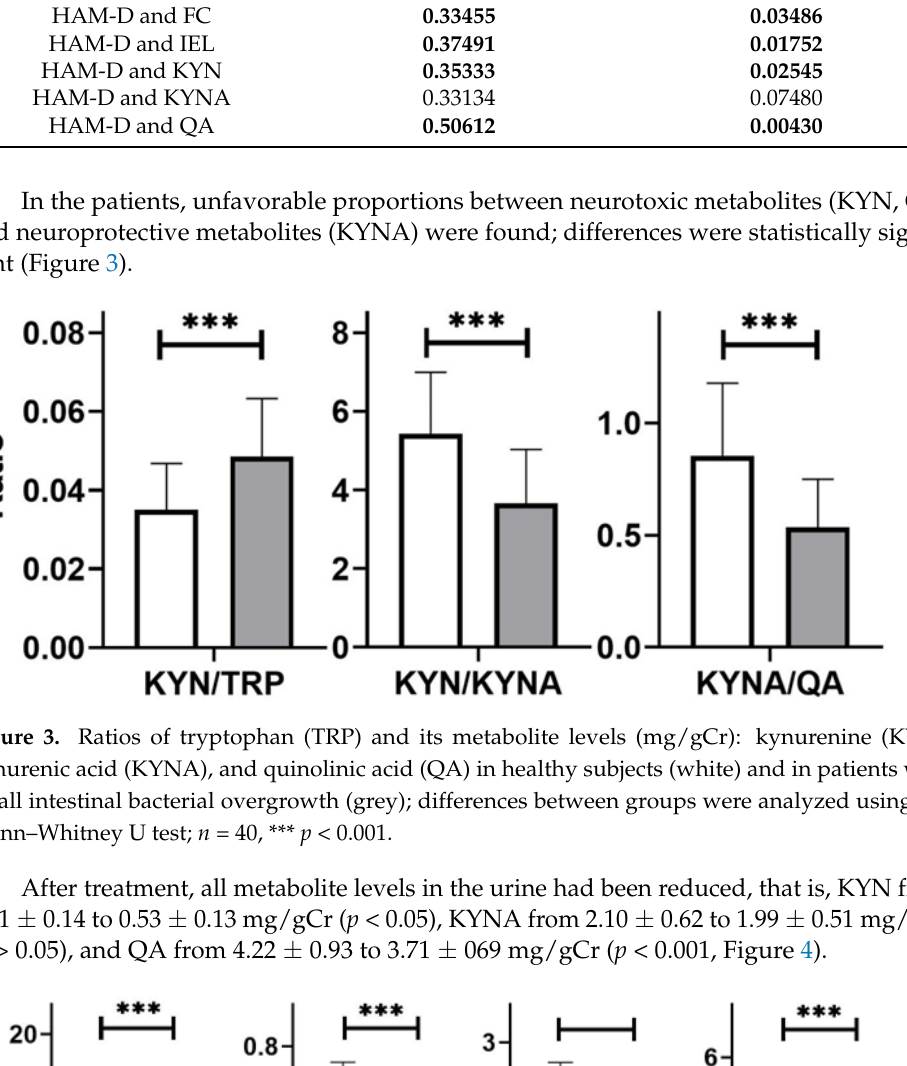
Table 2. Correlation between the Hamilton Depression Rating Scale (HAM-D) score and laboratory data; LHBT — hydrogen breath test, CRP — C -reactive protein, FC — fecal calprotectin, IEL — intraep- ithelial lymphocytes, KYN — kynurenine, KYNA — kynurenic acid, QA — quinolinic acid in 40 pa- tients ’ small intestinal bacterial overgrowth. The correlations were analyzed using the Spearman test. Significant p -values are highlighted in bold. A Pairs of Variable Rho-Spearman p -Value HAM-D and LHBT 0.36024